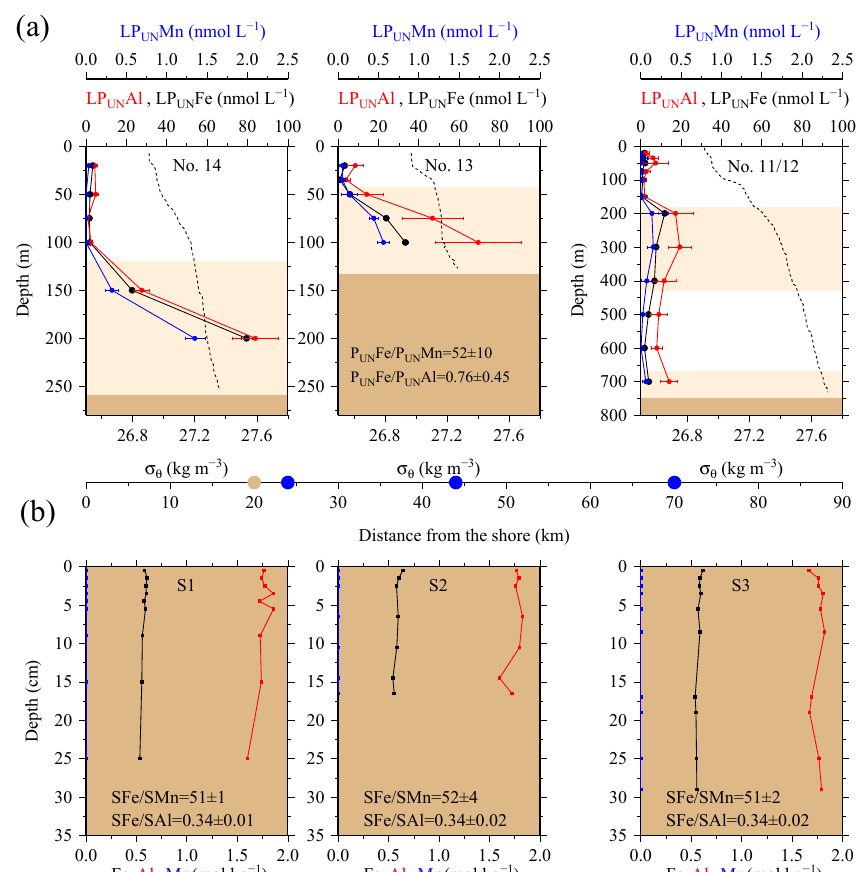
Figure 4. (a) OTE seawater samples: from left to right, concentrations of leachable particulate iron (LP Un Fe), aluminium (LP Un Al), and manganese (LP Un Mn) of unfiltered seawater samples for the two shelf sites (#14, #13) and the shelf edge site (#11/12) (note different depth scaling). Error bars represent the standard deviation of the analysis. Water density ( σ θ ) is shown by the dashed black line. Brown areas represent sediments, and pink areas the zone of resuspended sediment particles in the water column. Diagram 14 (left) contains the average LP Un Fe / LP Un Al and LP Un Fe / LP Un Mn ratio of particles in seawater samples collected within the pink layers. (b) sediment core samples: diagram of S1, S2, and S3 displaying the Fe, Mn, and Al content in the three sediment cores. Shown are average SFe / SAl and SFe / SMn ratios (molmol − 1 ) of particles from the surface layer for sites S1, S2, and S3. Dots on the distance scaling in the middle represent the distance of each water column station (blue) and sediment core (brown) station to the nearest